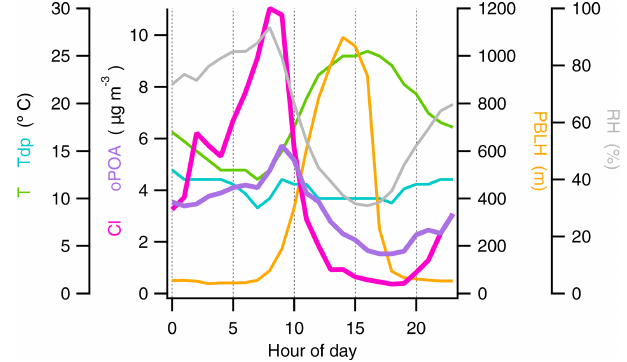
Figure 5. Diurnal median values of meteorological parameters, Cl − and oPOA concentrations in